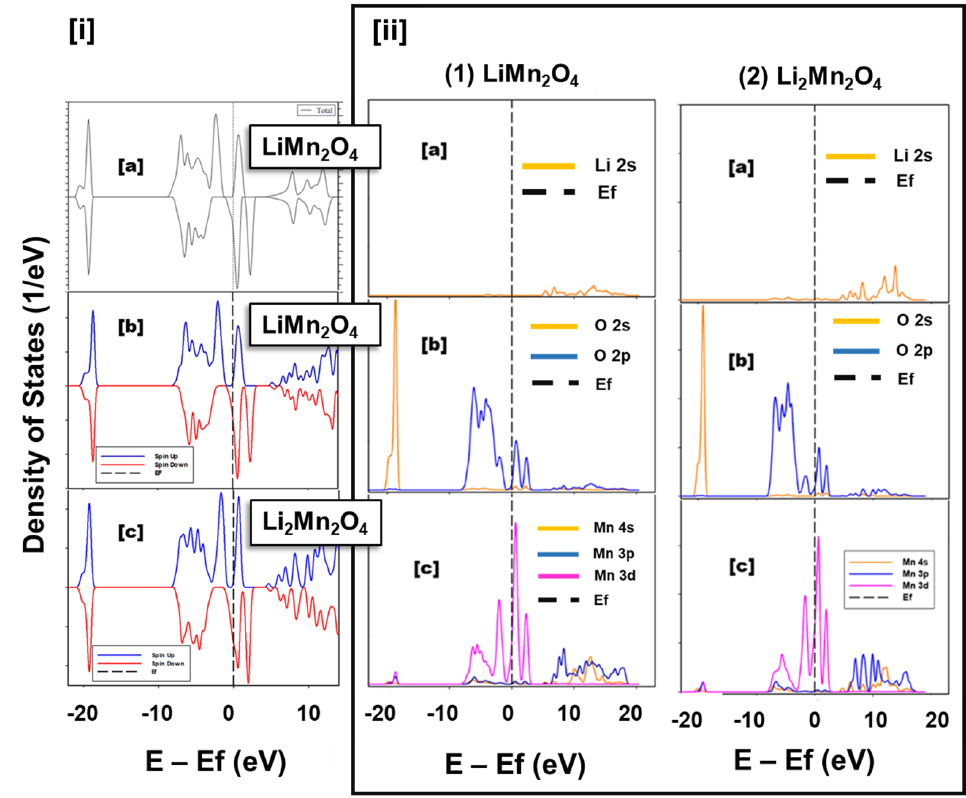
Figure 3. ( i ) Illustrates Spin polarized total density of states (DoS) for cubic spinel (a) LiMn 2 O 4 (literature) [30], (b) LiMn 2 O 4 (this work) and (c) Li 2 Mn 2 O 4 (this work); ( ii ) Partial DoS for spin polarised cubic spinel (1) LiMn 2 O 4 and (2) Li 2 Mn 2 O 4 , with (a) contributions from lithium, (b) oxygen and (c) manganese atoms. Figure 3(ia) reprinted with permission from Ref. [30]. 2022, Elsevier.